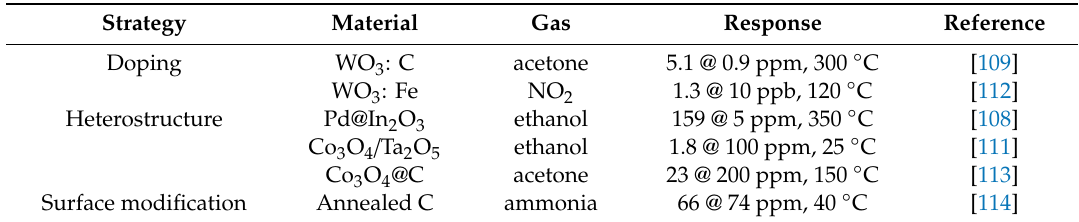
Table 2. Summary of carbon sphere template derived hollow nanostructure for gas